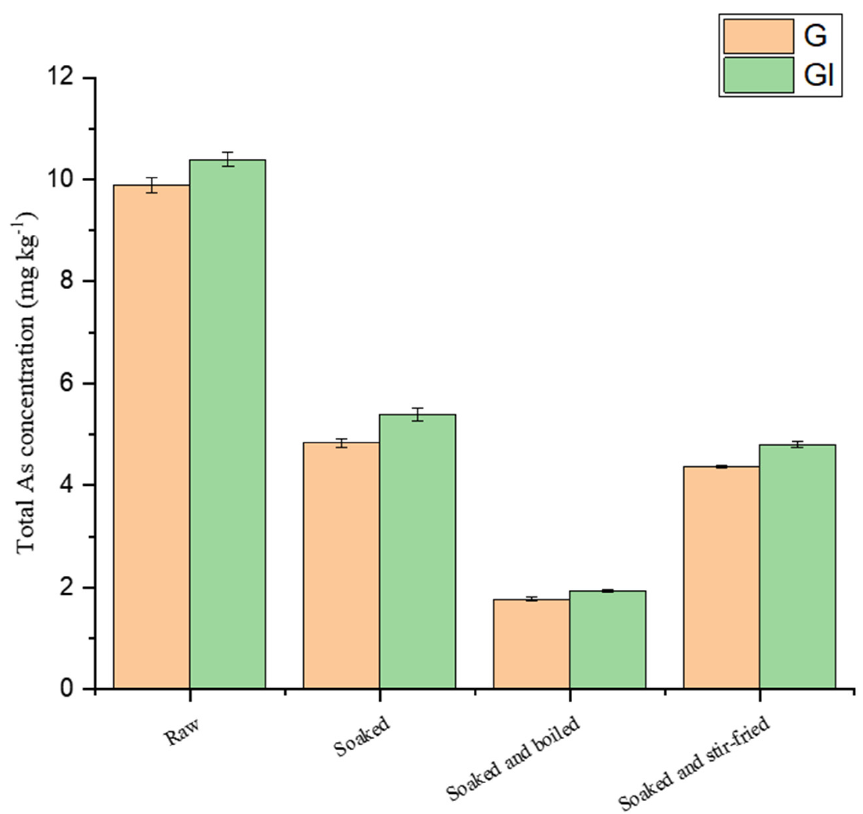
Figure 4. As content in G and GI fractions of Pleurous citrinipileatus after different treatments.